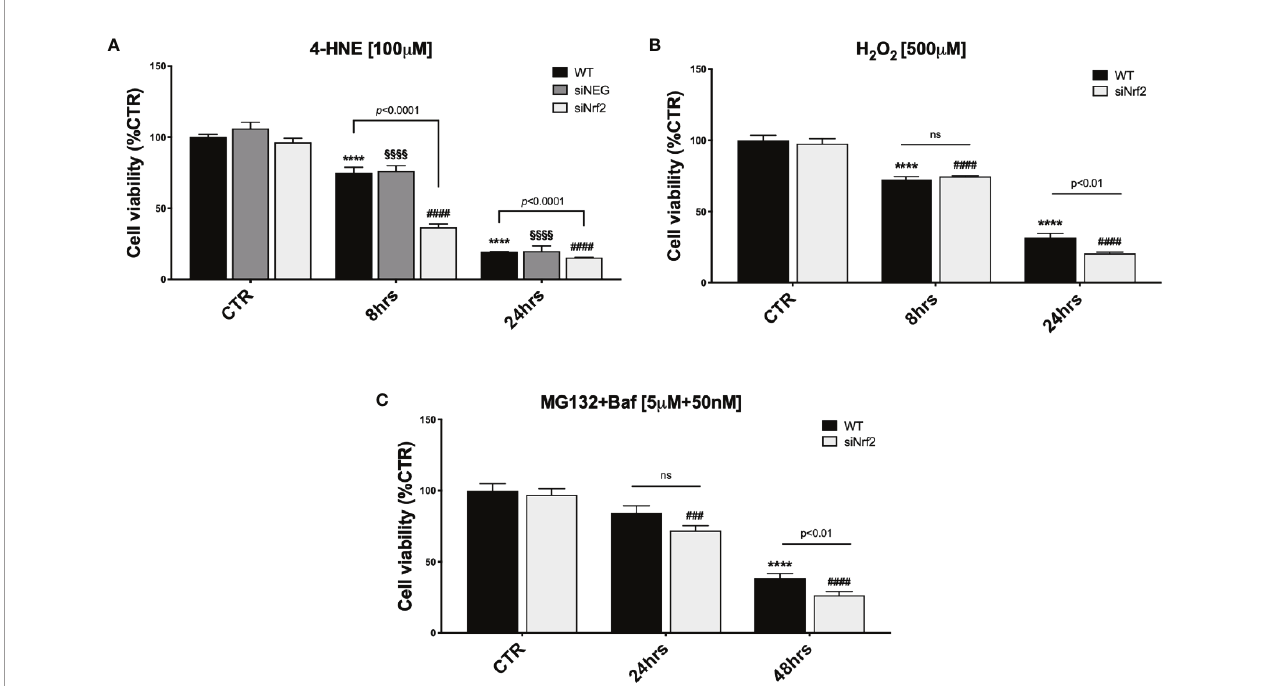
FIGURE 1 | The Nrf2-impaired ARPE-19 cells are more susceptible to stress than their WT counterpart. Cell viability was assessed by a fl uorometric assay (PrestoBlue ® ) and results are expressed as mean of percentages ± SEM. (A) WT, siNEG, and siNrf2 ARPE-19 cells were treated with either solvent (DMSO, CTR) or 4-HNE [100 m M] for 8 and 24 h. Dunnett ’ s multiple comparisons test; ****p < 0.0001 versus WT CTR; §§§§ p < 0.0001 versus siNEG CTR; and #### p < 0.0001 versus siNrf2 CTR; ns = non signi fi cant; n = 5 – 8. (B) WT and siNrf2 ARPE-19 cells were treated with either solvent (DMSO, CTR) or H 2 O 2 [500 m M] for 8 and 24 h. Sidak ’ s multiple comparisons test; ****p = 0.0001 versus WT CTR; #### p < 0.0001 versus siNrf2 CTR; n = 6 – 8. (C) WT and siNrf2 ARPE-19 cells were treated with either solvent (DMSO, CTR) or MG132 + Ba fi lomycin [5 m M + 50 nM] for 24 and 48 h. Sidak ’ s multiple comparisons test; ****p < 0.0001 versus WT CTR; ### p < 0.001